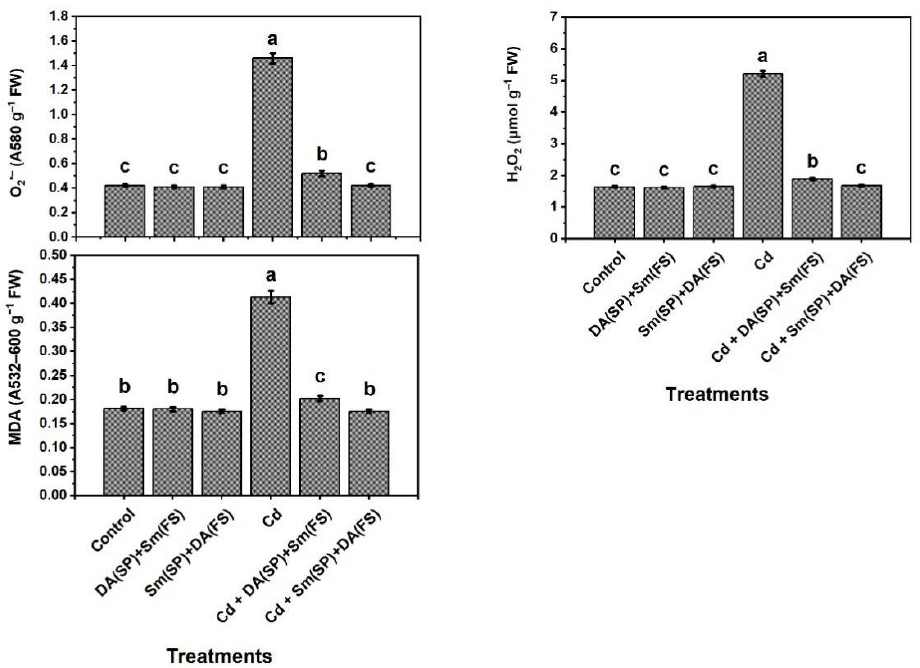
Figure 5. Effects of seed priming (SP) and foliar spraying (FS) with silymarin (Sm) or dopamine (DA) on stress marker levels of cadmium-stressed Phaseolus vulgaris plants. Columns labeled with same or different letters within each plot signify non-significant or significant differences, respectively, based on LSD test ( p ≤ 0.05). Bars represent SE values (three replicates). O 2 •− = Superoxide radical, H 2 O 2 = Hydrogen peroxide, and MDA = Malondialdehyde.